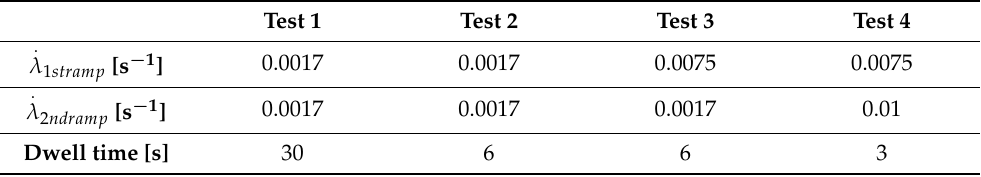
Table 4. Velocity values and dwell time applied during the